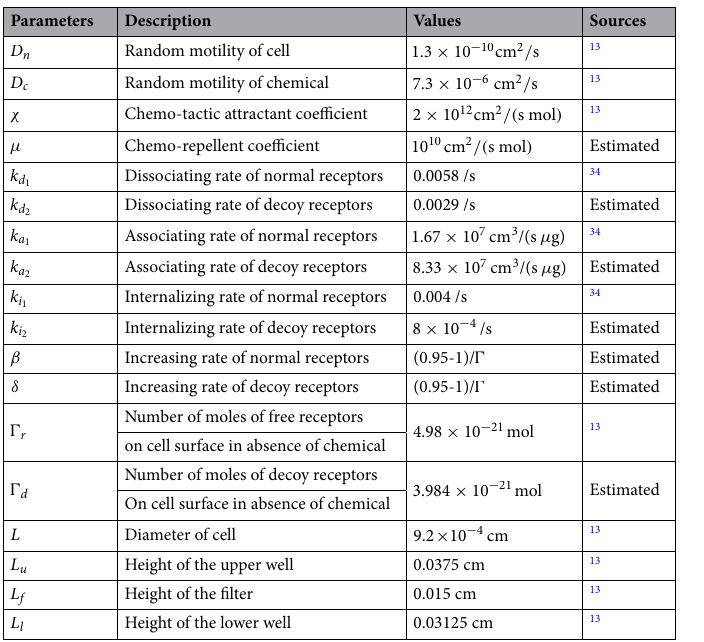
Table 2. Description of the parameters used in the